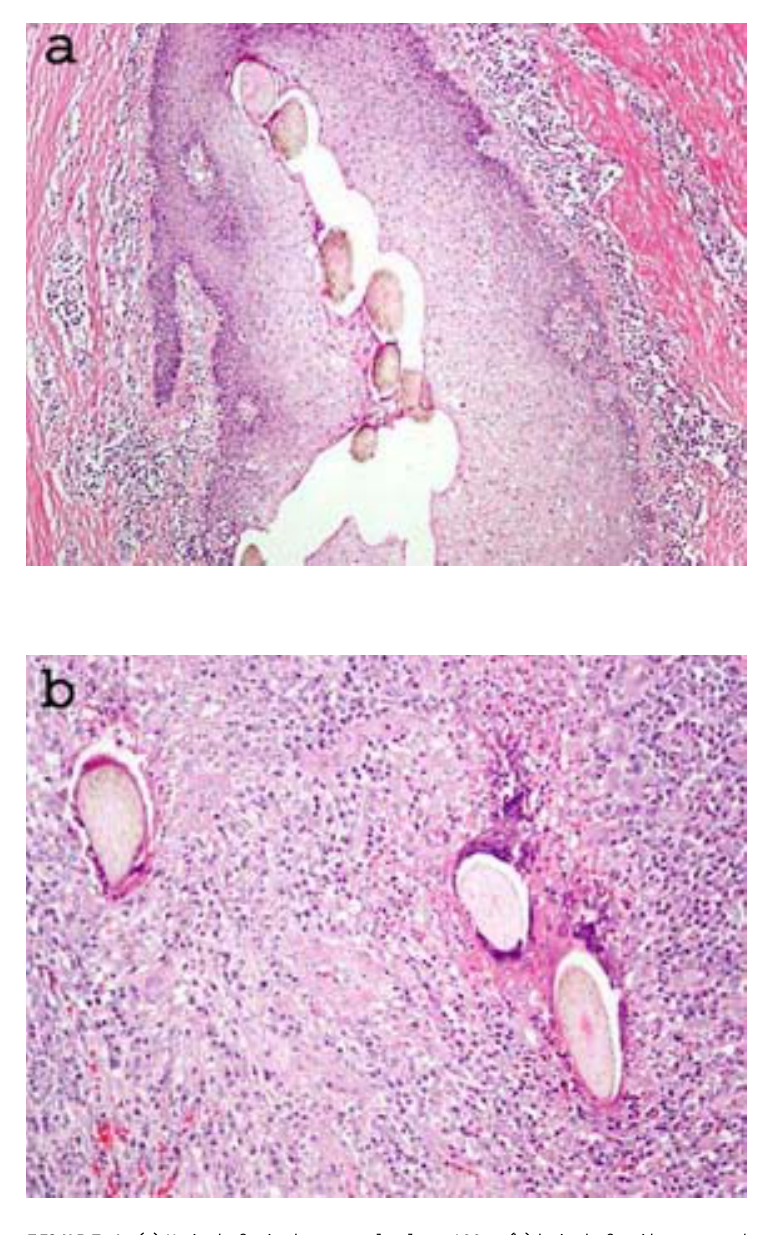
FIGURE 1. (a) Hair shafts in the coronal sulcus, 100 × ; (b) hair shaft with acute and chronic inflammation and foreign-body giant cell reaction, 100 ×